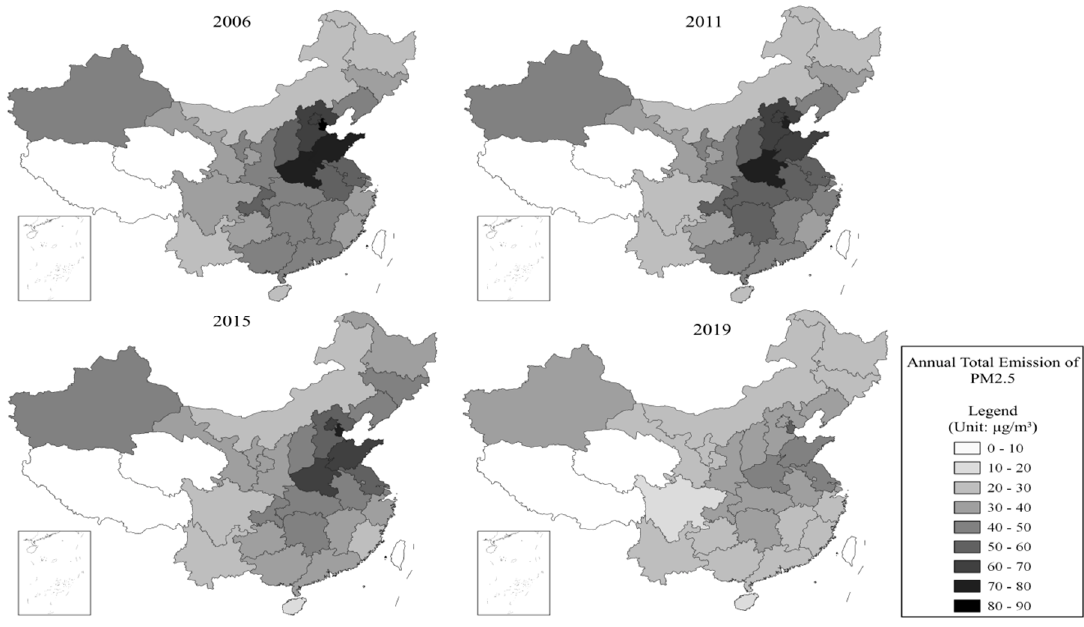
Figure 5. Distribution of PM 2.5 in different provinces of China from 2006 to 2019.